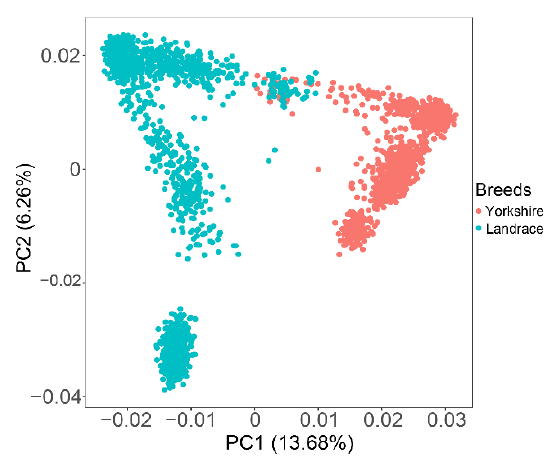
Figure 1. Principal component analysis shows the population structure between Landrace and Yorkshire pigs. Top two principal components: PC1 = 13.68%; PC2 = 6.26%.